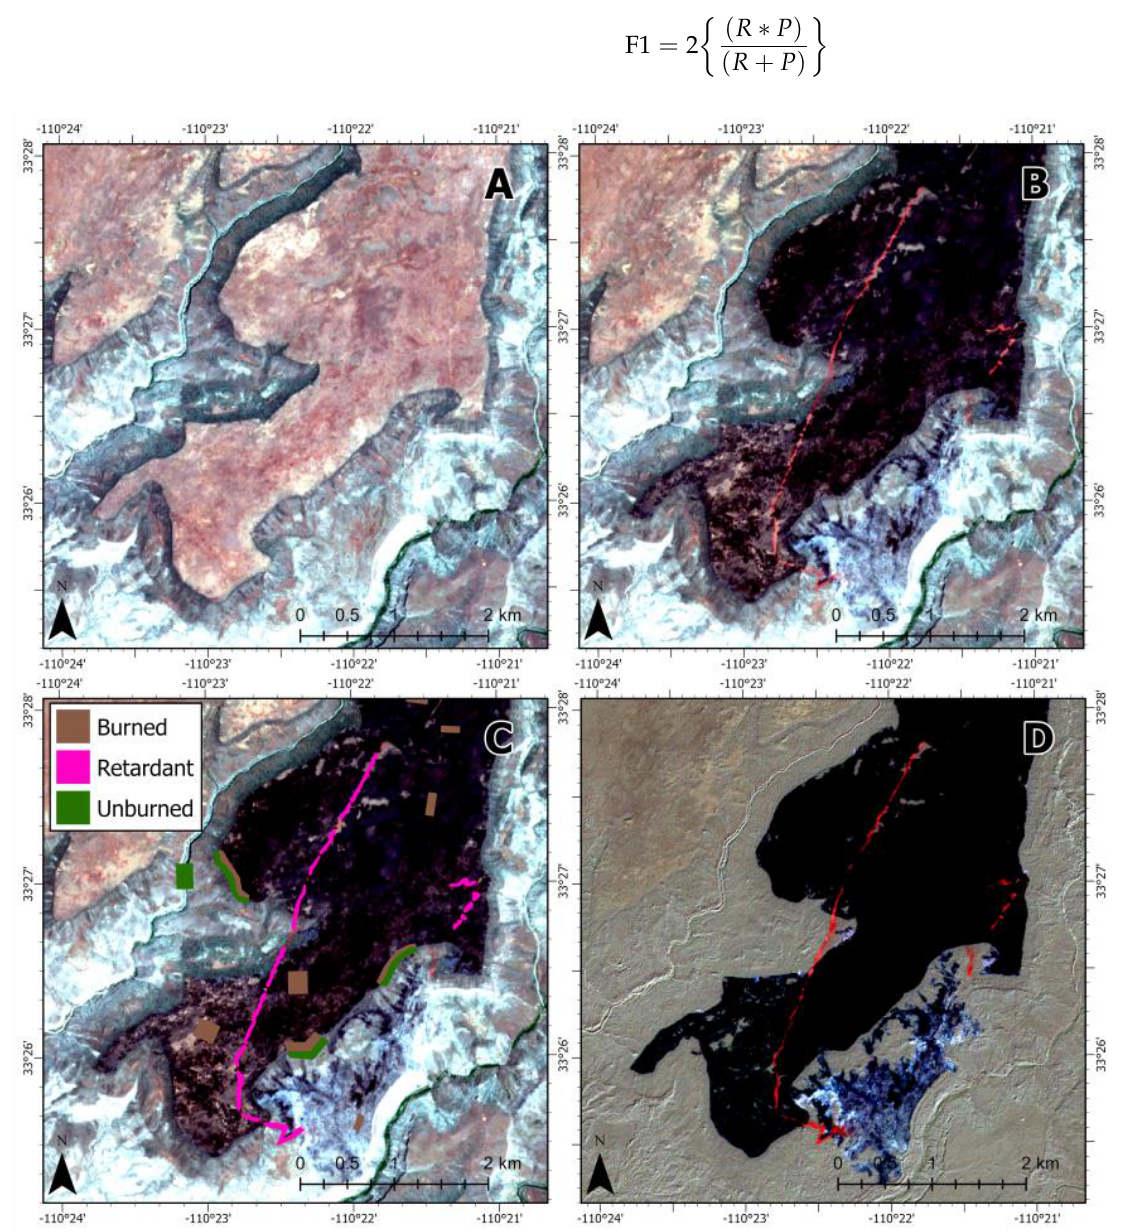
Figure 3. Sentinel-2 true-color imagery from the Blue River (Arizona, 2020) fire: ( A ) pre-application; ( B ) post-application; ( C ) post-application with reference labels; ( D ) difference image post-application minus pre-application.